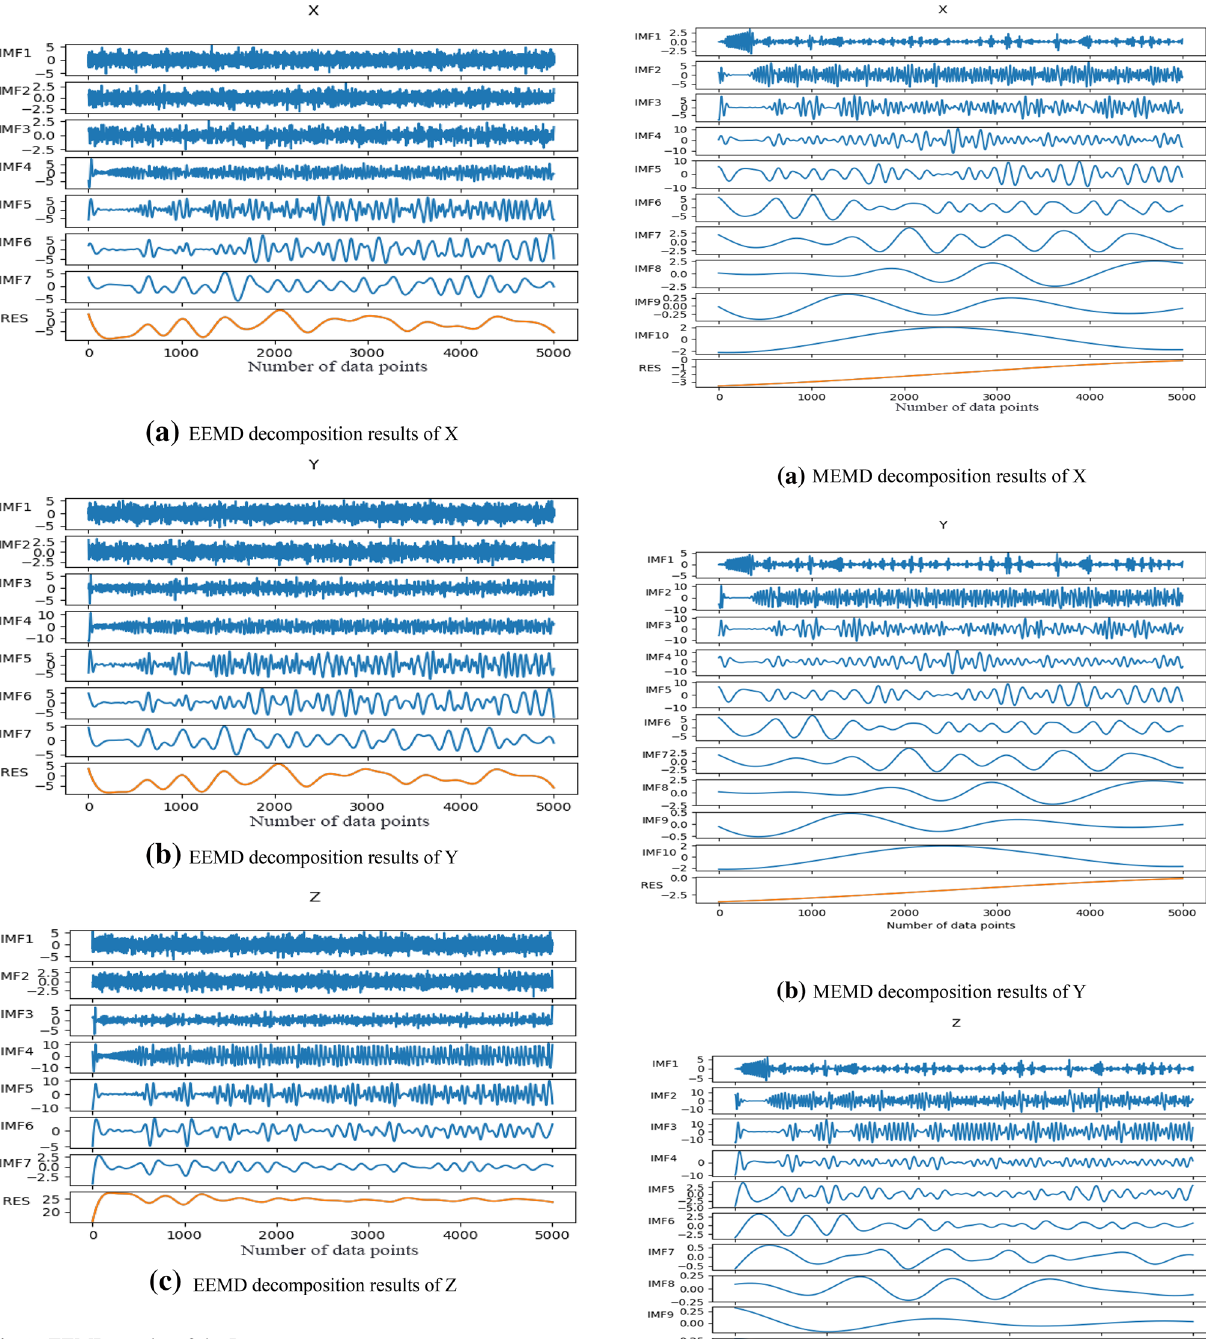
Fig. 2 EEMD results of the Lorenz system